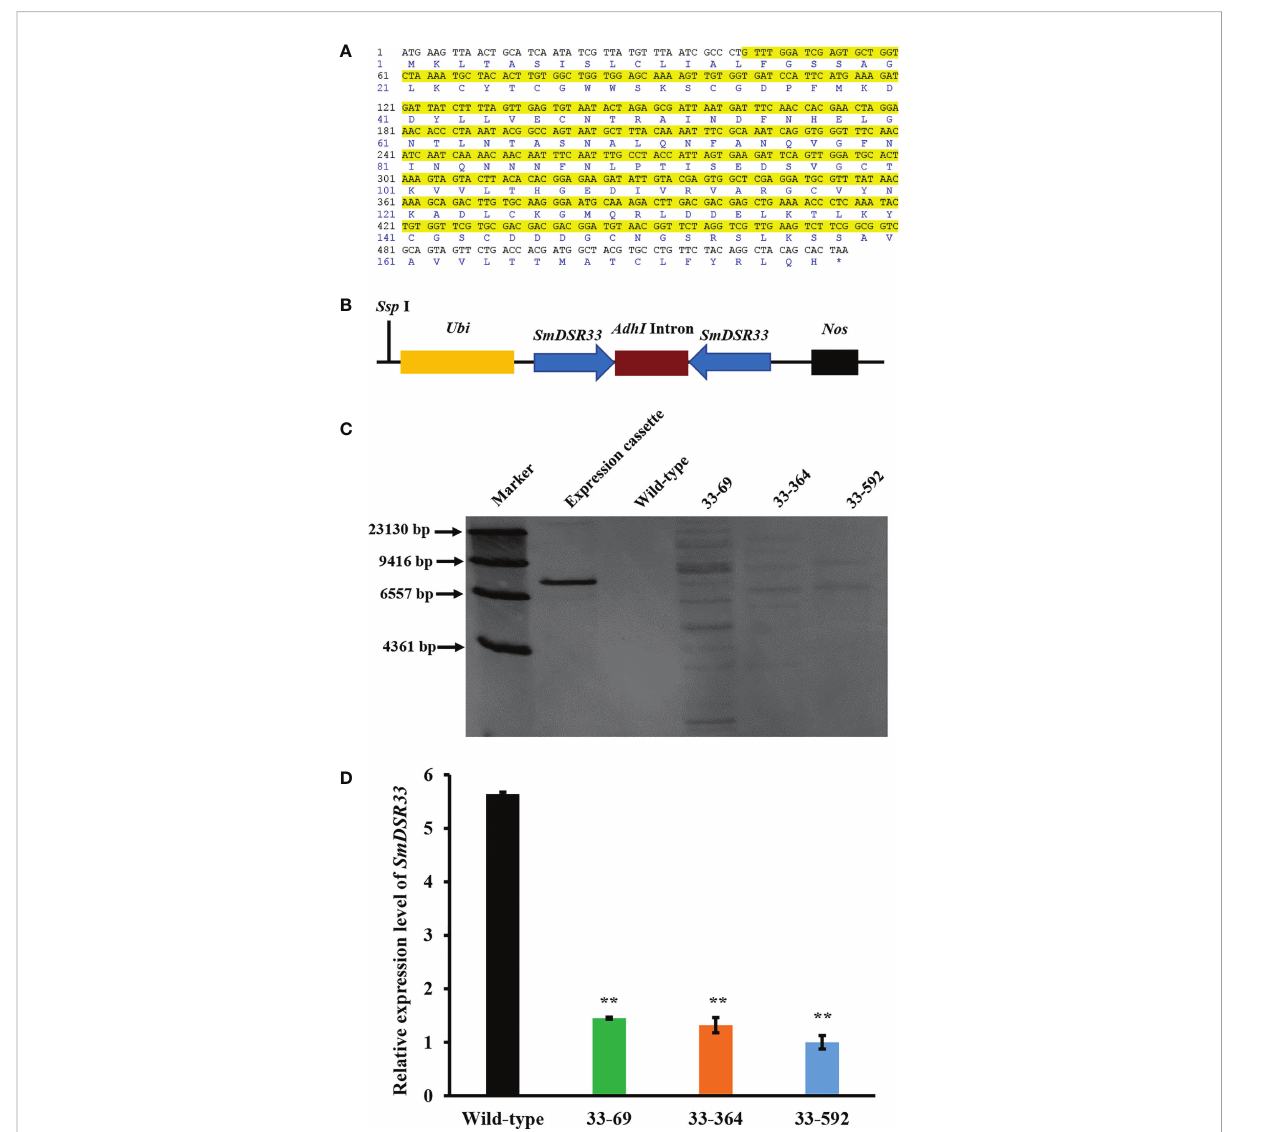
FIGURE 2 RNAi induced silencing of SmDSR33 gene in wheat. (A) The encoding sequence of SmDSR33 and its deduced amino acid sequence. The sequences selected for construction of the RNAi vector are highlighted in yellow. (B) A schematic show of the SmDSR33 expression cassette and position of Ssp I restriction enzyme. (C) Southern blot analysis of the transgenic wheat lines. Genomic DNA was digested with Ssp I and hybridized with a SmDSR33 gene fragment with the expression cassette digested with Ssp I as a positive control. (D) Relative expression levels of SmDSR33 of grain aphid fed on wild-type and transgenic wheat lines. The expression level of SmDSR33 in the adult aphids fed on wild-type and different transgenic wheat lines after inoculation of one-day-old newborn nymphs, respectively. Values and error bars represent the mean and SEM of three independent biological replicates, each with a pool of 15 surviving individual aphids (Student ’ s t -test, ** P